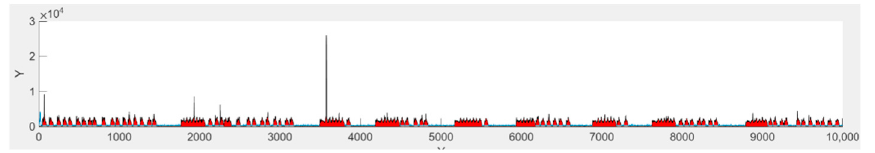
Figure 11. Section of evaluated peaks at the 20% filling degree, which shows an unsteady flow pattern with single droplets as well as droplet chains.